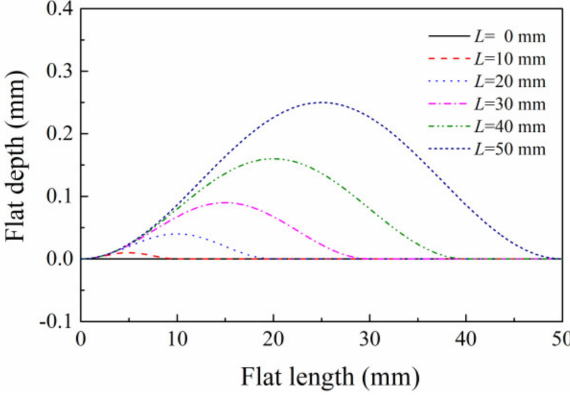
Figure 10. Profile of wheel